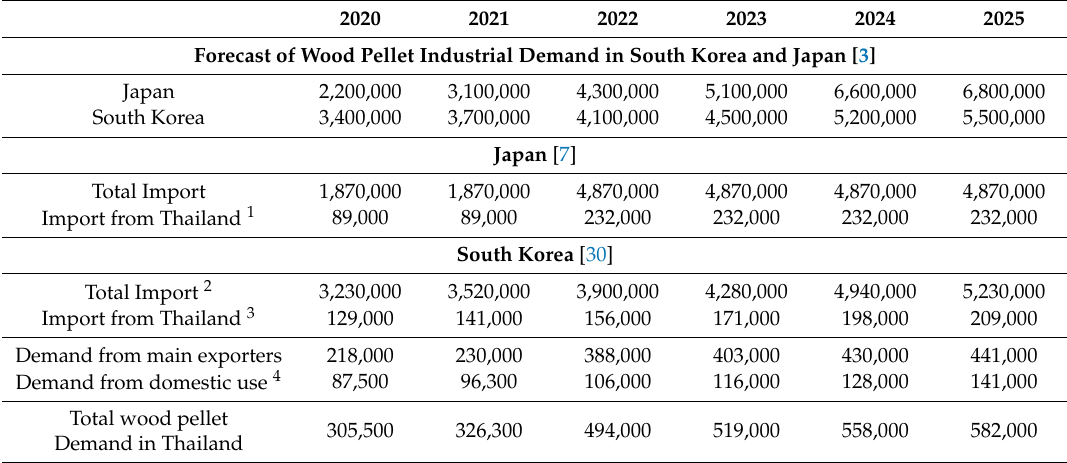
Table 3. Evaluation of wood pellet demand based on policy of importers and Thai government